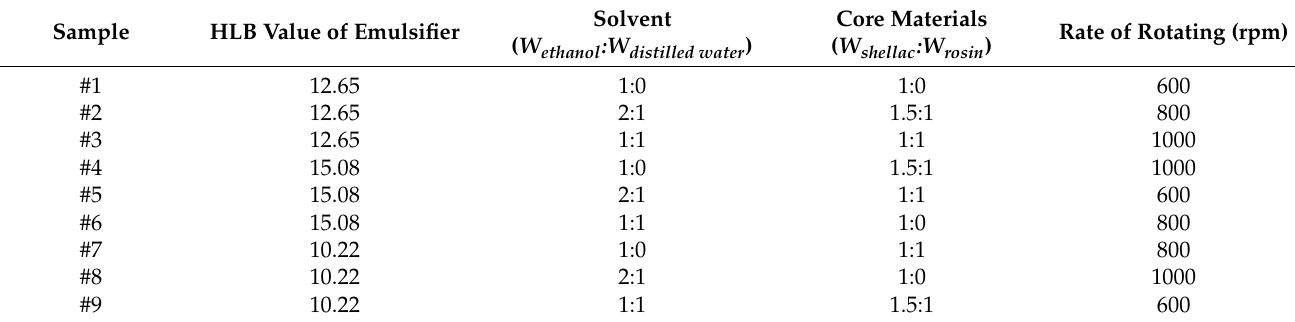
Table 3. The arrangement of orthogonal experiment.